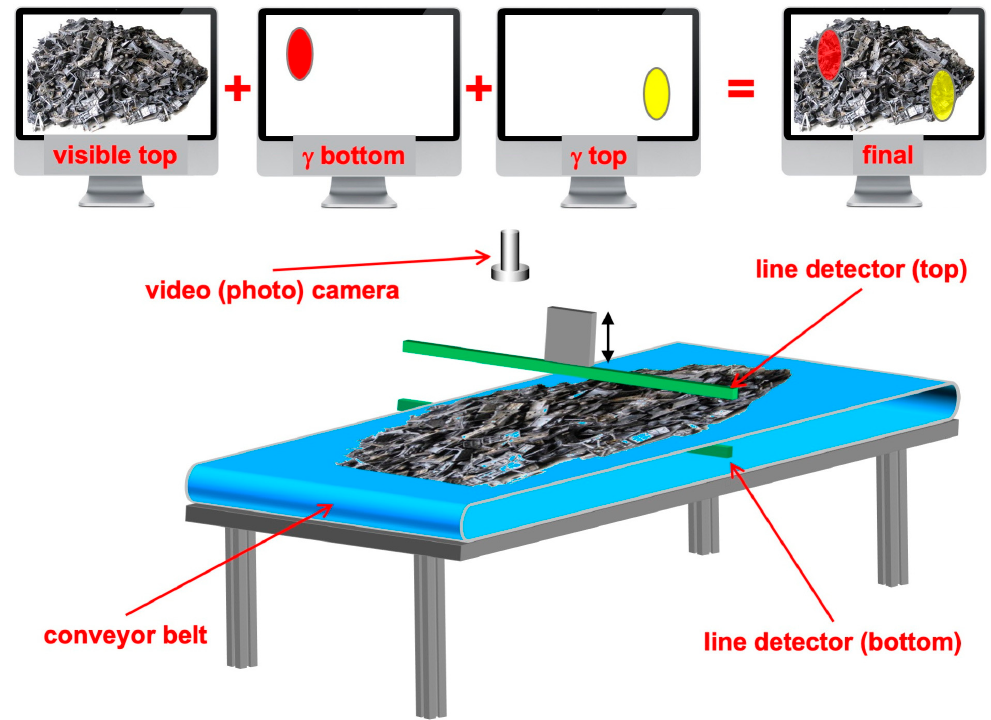
Figure 15. Sketch of a possible radwaste scanner based on a conveyor belt, a video camera and two linear arrays of detectors. The bottom array would be embedded in the conveyor, while the top one would be installed on an up–down actuator in order to be moved closer to the materials to be